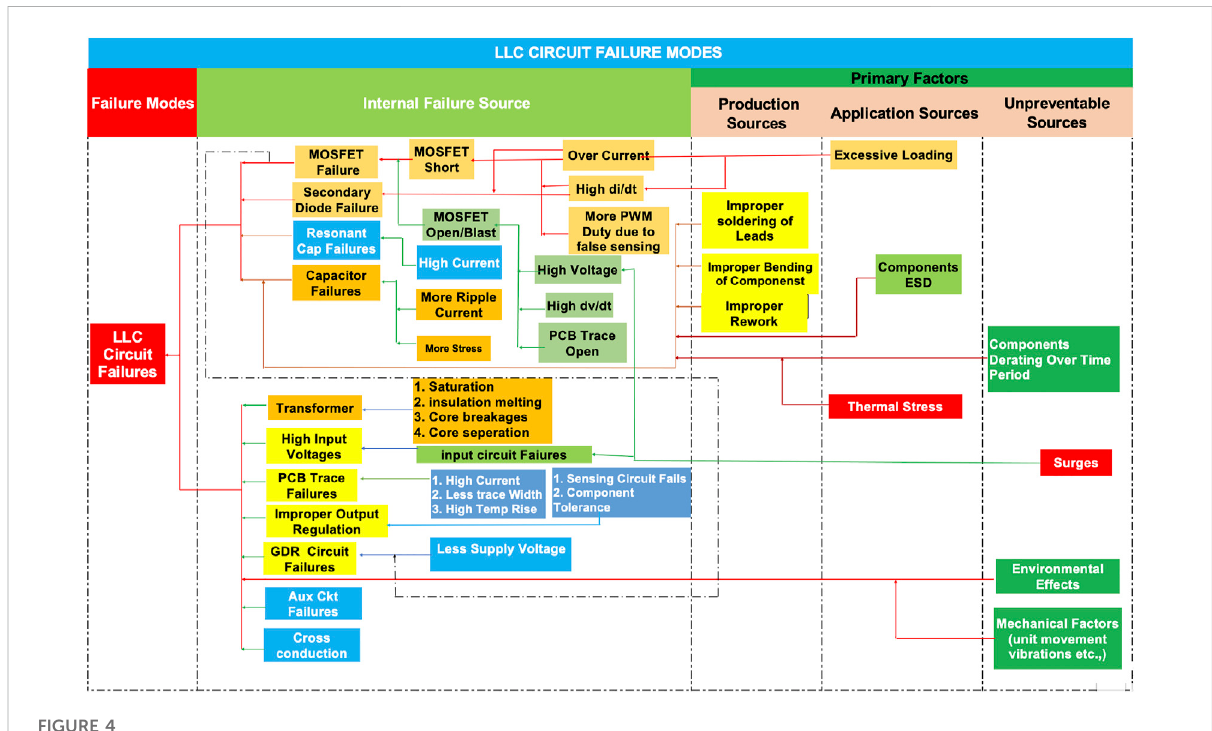
FIGURE 4 LLC converter failure